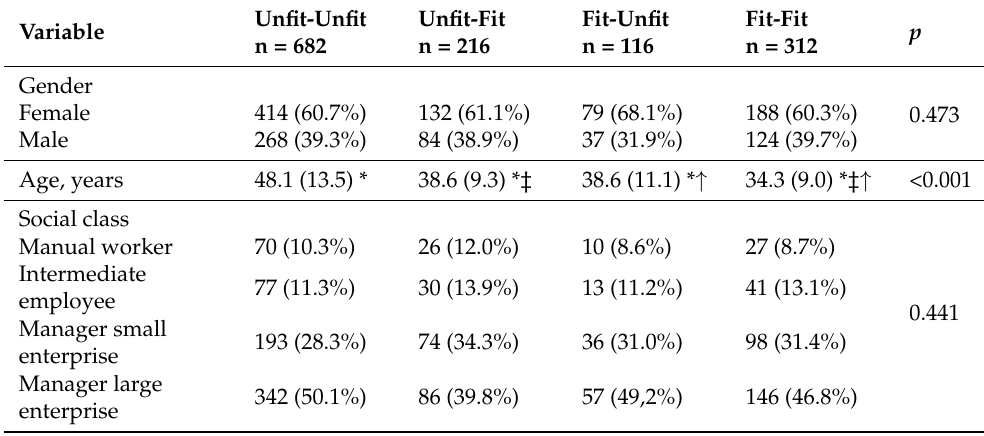
Table 2. Participants’ characteristics of sample individuals across the four groups of change in cardiorespiratory fitness at 12